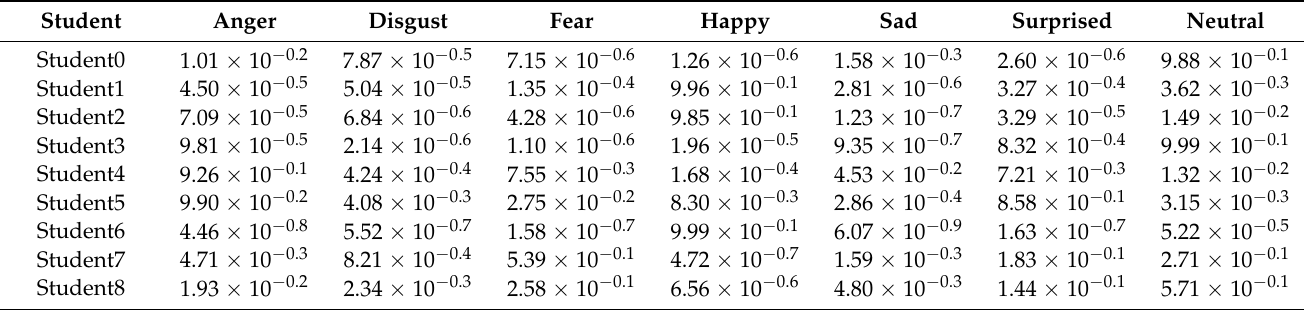
Table 2. Expression recognition confidence.